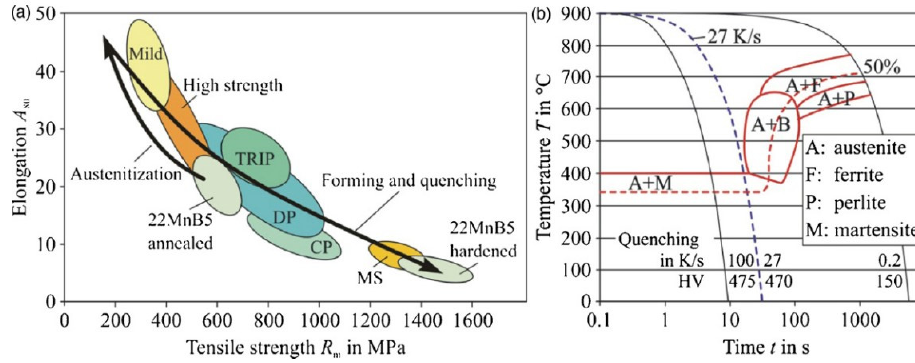
Figure 1. ( a ) Mechanical properties of 22MnB5 and ( b ) CCT diagram